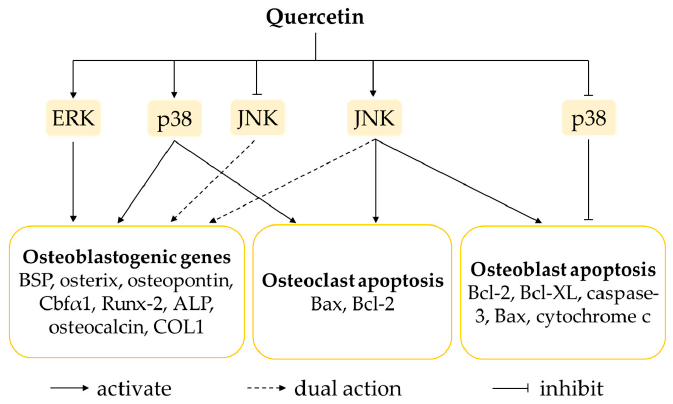
Figure 2. The effects of quercetin on MAPK (ERK, p38 MAPK and JNK) signalling pathways. The Figure 2. The e ff ects of quercetin on MAPK (ERK, p38 MAPK and JNK) signalling pathways. The activations of ERK and p38 MAPK favour osteogenesis, whereas the activation of JNK positively and negatively regulates osteogenesis. The activations of p38 MAPK and JNK contribute to the induction of osteoblast and osteoclast apoptosis. Quercetin activates ERK but exerts a dual action on p38 MAPK and JNK. Abbreviation: ALP = alkaline phosphatase; Bax = Bcl-2-associated X protein; Bcl-2 = B-cell lymphoma 2; Bcl-XL = B-cell lymphoma-extra large; BSP = bone sialoprotein; Cb α 1 = core binding factor alpha 1; COL1 = type 1 collagen; ERK = extracellular signal-regulated kinase; JNK = c-Jun N-terminal kinase; Runx-2 = runt-related transcription factor